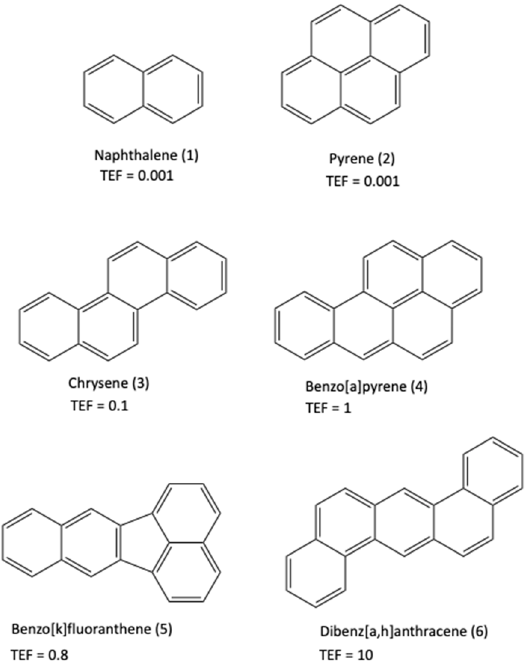
Figure 1. Polycyclic aromatic hydrocarbons used in this study.